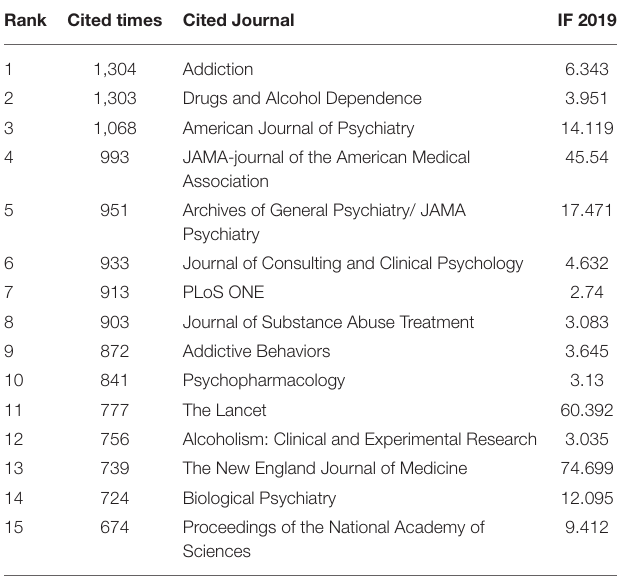
TABLE 5 | Top 15 cited journals related to complementary and alternative medicine for substance use